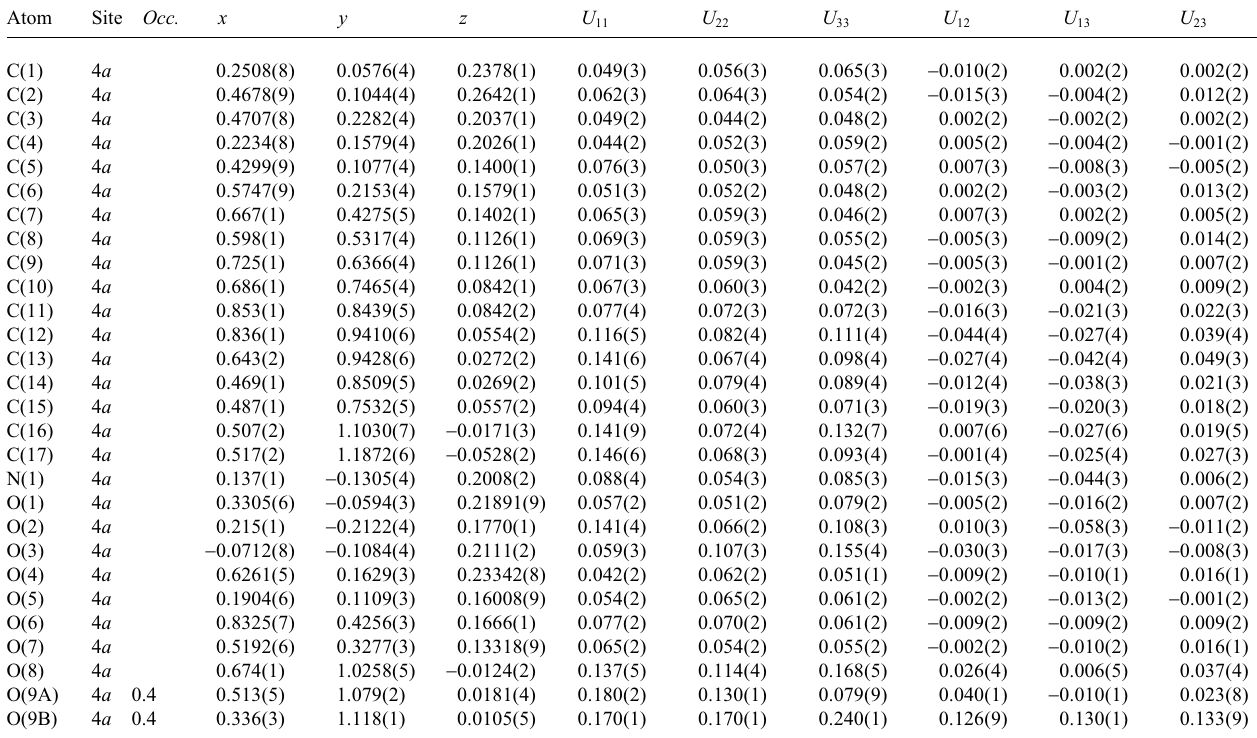
Table 3. Atomic coordinates and displacement parameters (in Å 2 ) . Atom Site